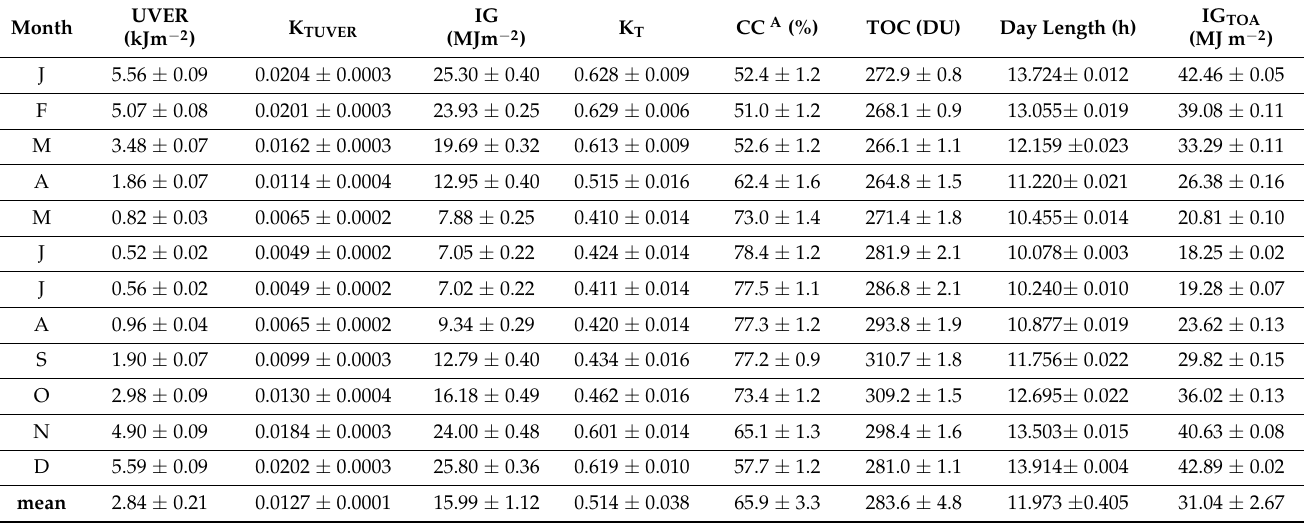
Table 2. Monthly average daily values (standard error) of ultraviolet erythemal radiation (UVER)and related variables under all-sky conditions from 2015 to 2019 for